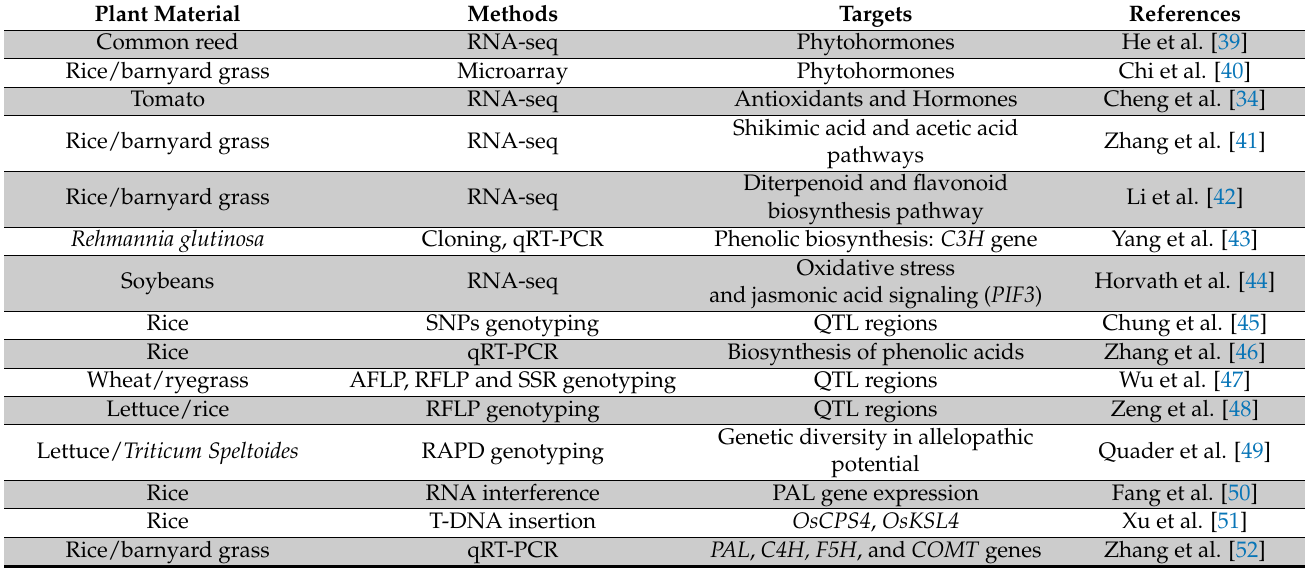
Table 1. Representative articles of the genetic and genomic approaches in